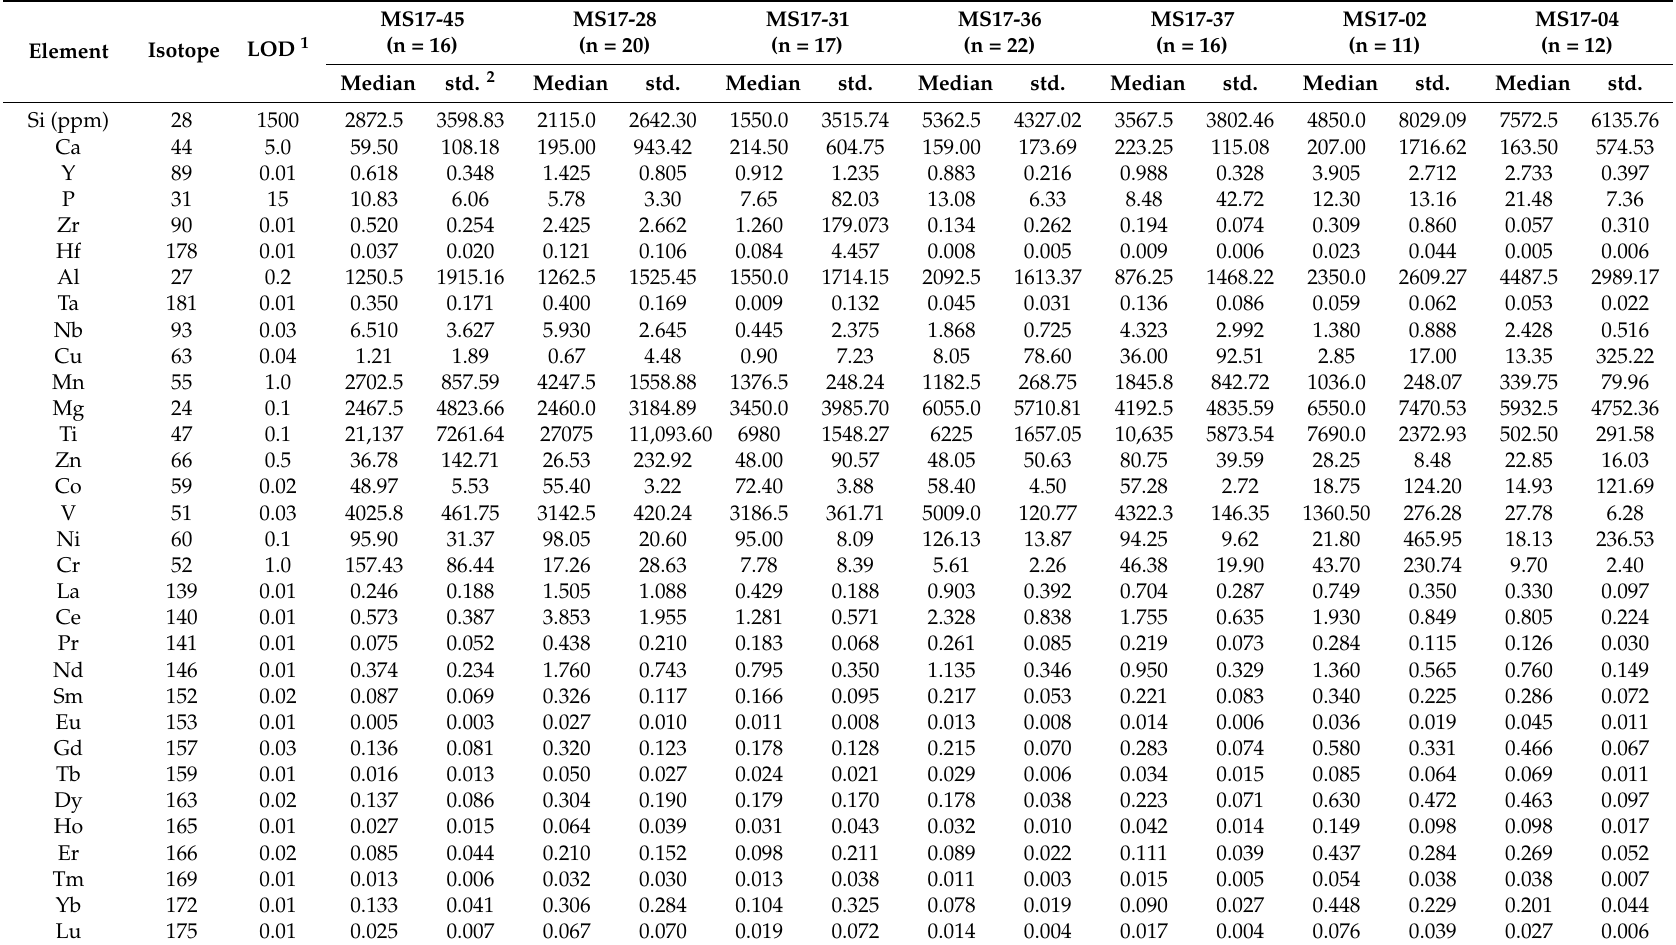
Table 2. Average chemical compositions of magnetite analyzed by LA-ICP-MS in LDC